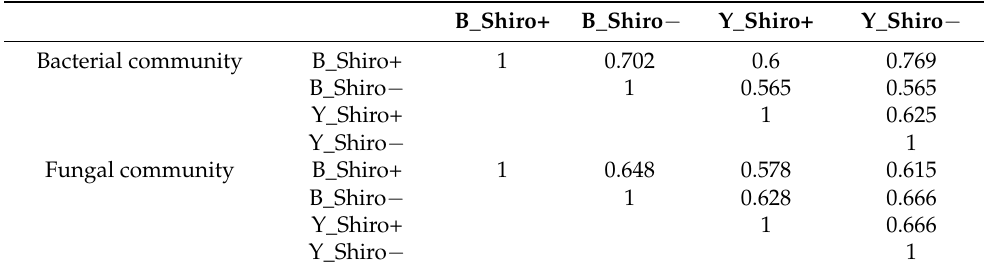
Table 6. The results of Sorensen’s classic similarity index of bacterial and fungal communities within/across sampling